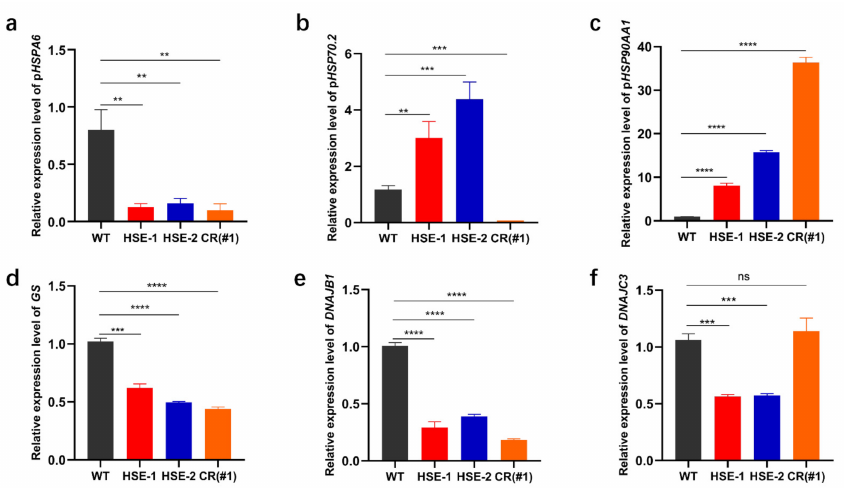
Figure 5. Effects of the three regulatory regions on the expression of other genes after thermal treatment. ( a ) HSE-1, HSE-2, and CR significantly reduced the expression of p HSPA6 . ** p < 0.01. ( b ) The expression of p HSP70.2 was negatively correlated with changes in p HSPA6 in clones HSE- 1 and HSE-2 but positively correlated with CR. ** p < 0.01, *** p < 0.001. ( c ) The expression of p HSP90AA1 was negatively correlated with changes in p HSPA6 in clones HSE-1, HSE-2, and CR. **** p < 0.0001. ( d ) The expression of GS was positively correlated with changes in p HSPA6 in clones HSE-1, HSE-2, and CR. *** p < 0.001, **** p < 0.0001. ( e ) The expression of DNAJB1 was positively correlated with changes in p HSPA6 in clones HSE-1, HSE-2, and CR. **** p < 0.0001. ( f ) The expression of DNAJC3 was positively correlated with changes in p HSPA6 in clones HSE-1 and HSE-2 but uncorrelated with CR. *** p < 0.001, ns = not